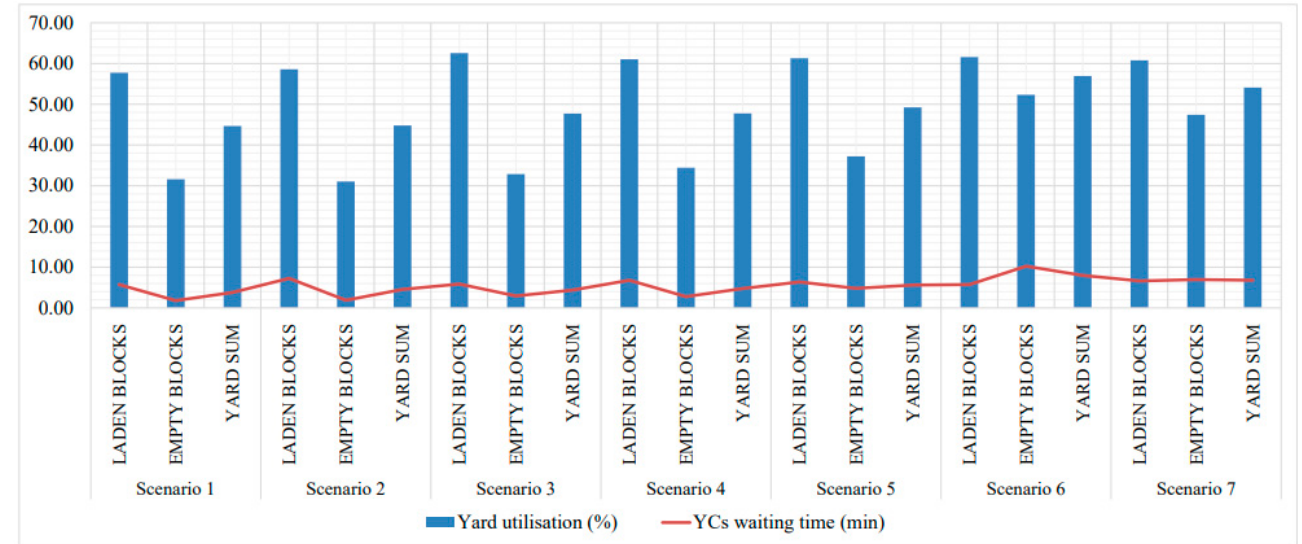
Figure 6. Graphical view of the yard results.